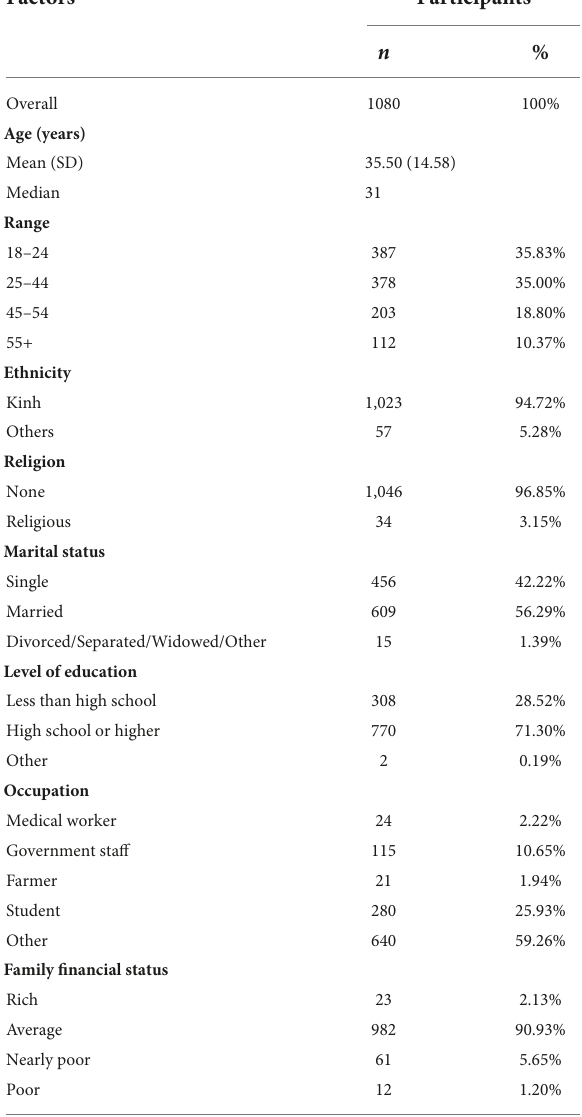
TABLE 2 Descriptive statistics of sociodemographic characteristics. Factors Participants